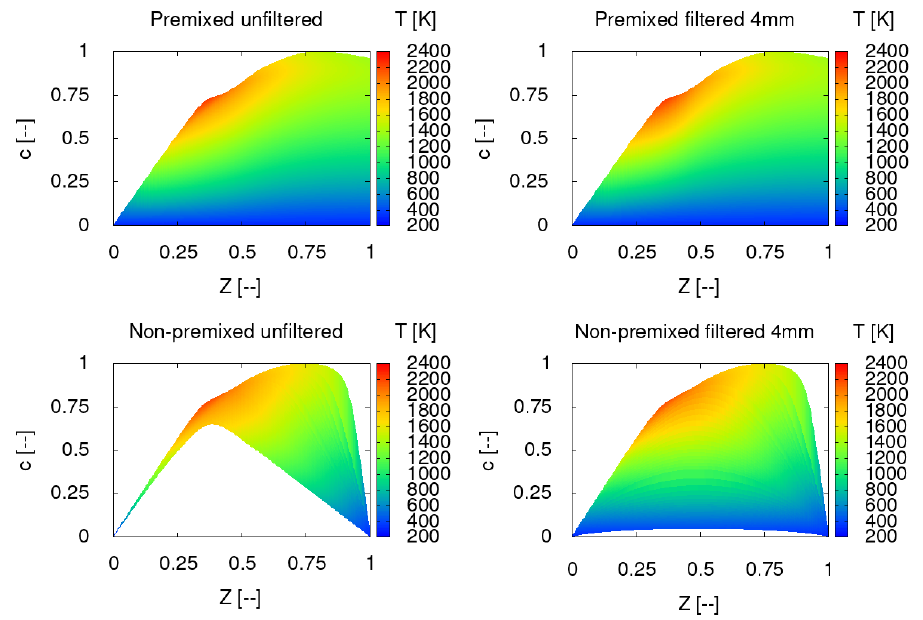
Figure 2. Temperature mapping for premixed ( top ) and non-premixed ( bottom )